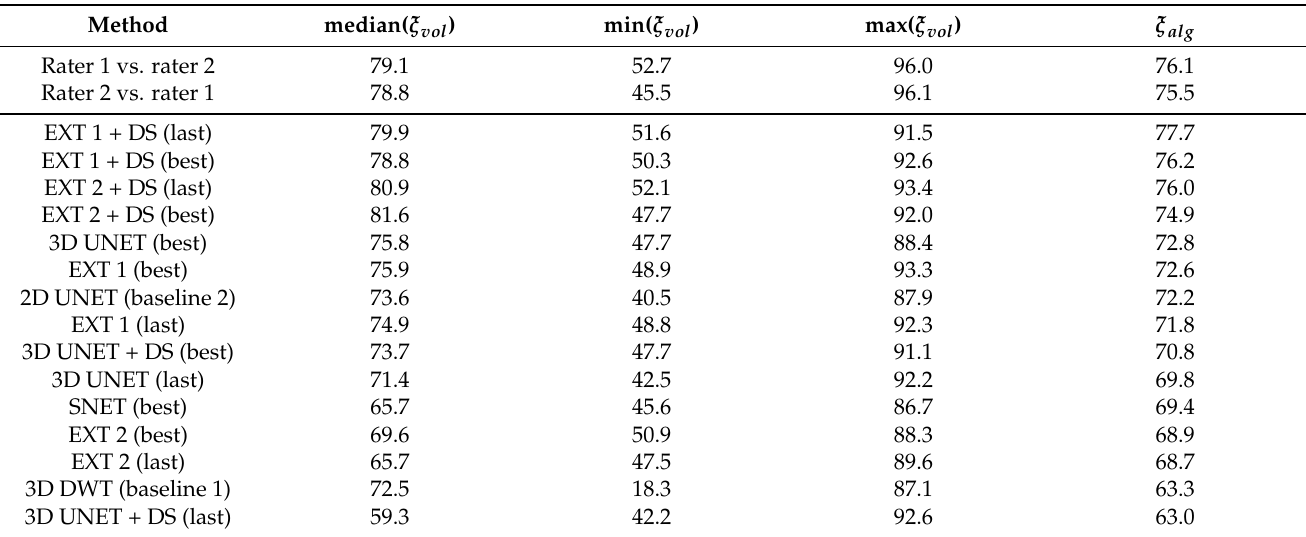
Table 6. Effectiveness of the proposed ovary detection methods compared to the state-of-the-art and inter-rater variability. The final score statistics are presented, together with the overall algorithm’s score on the USOVA3D database. Entries are sorted with respect to the overall score.